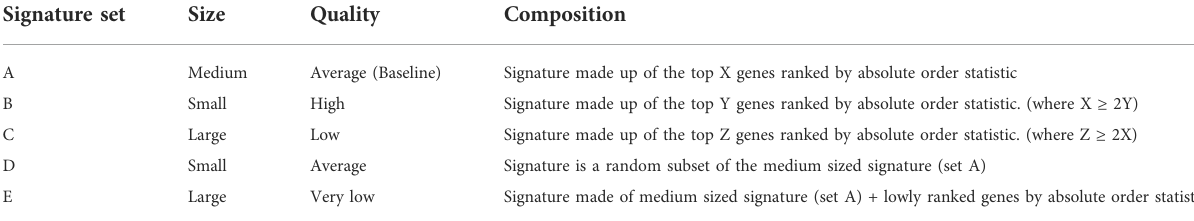
TABLE4Differentqualitylevelsofdiseasesignaturesanditscomposition.Orderstatisticofagene: abs ( LFC ) × − log 10 ( adjustedp − value ) .X=250for gastric cancer analysis; X = 120 for epilepsy